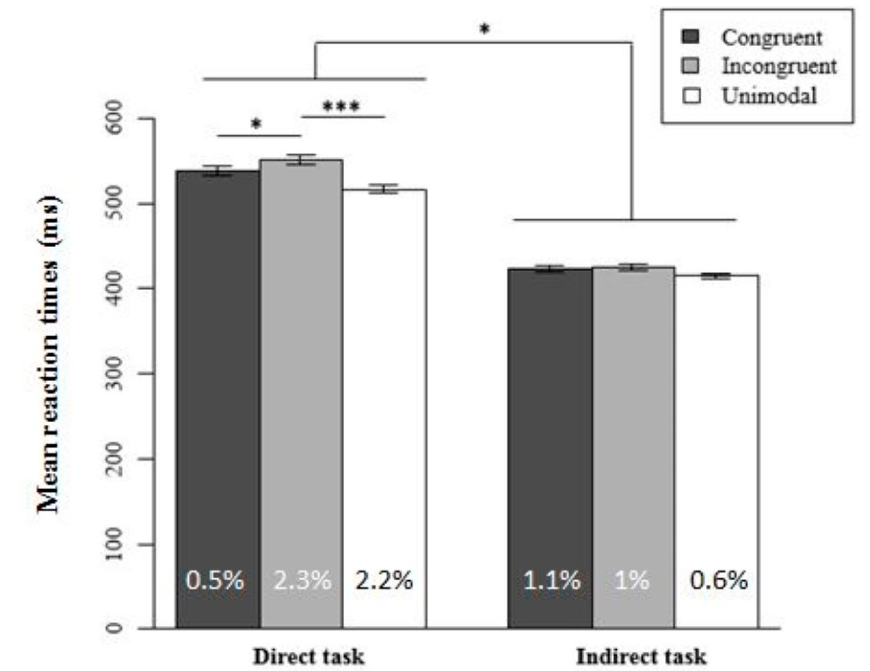
Figure 4. Mean reaction times as a function of the task and the congruency of the interaction for the pitch–size correspondence. Direct task: N = 23. Indirect task: N = 18. The mean percentage of errors for each condition is shown at the bottom of each column. Error bars represent the standard error of the mean across participants and the asterisks indicate significant statistical difference (* p < 0.05, *** p < 0.001).